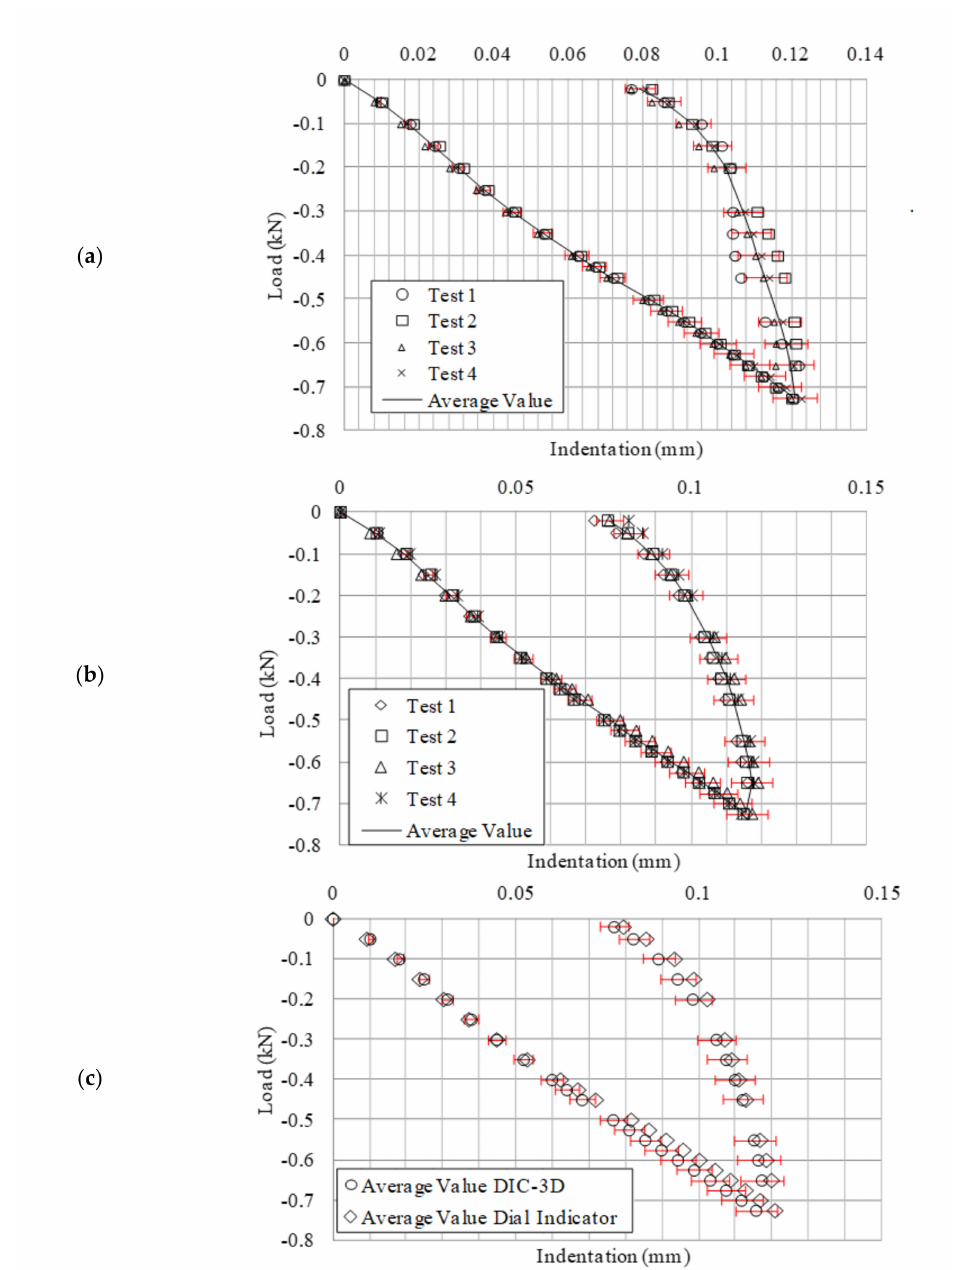
Figure 5. ( a ) Tests results for the dial indicator setup; ( b ) tests results for 3D-DIC setup; ( c ) results comparison using 3D-DIC and the dial